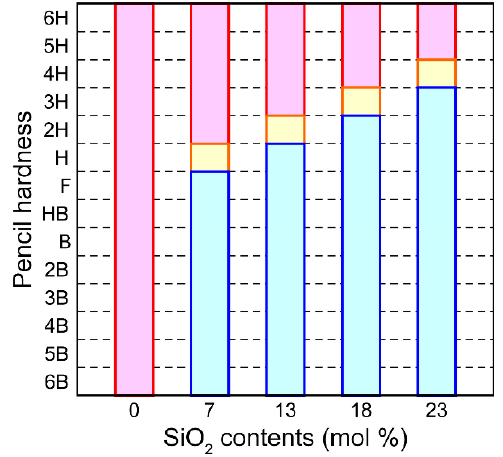
Figure 17. Pencil hardness test of trGO and trGO/SiO 2 films prepared at 800 °C. (Red: cohesive fracture, Yellow: plastic deformation, and Blue: no damage)